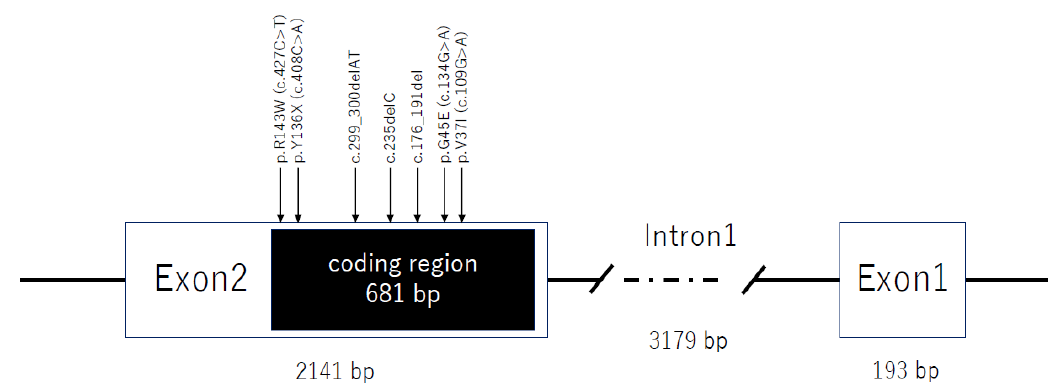
Figure 1. A schematic diagram showing the location of each mutation within the GJB2 gene. White boxes indicate exons, and the black box in exon 2 indicates the coding region. All six mutations targeted in this study exist in the coding region.